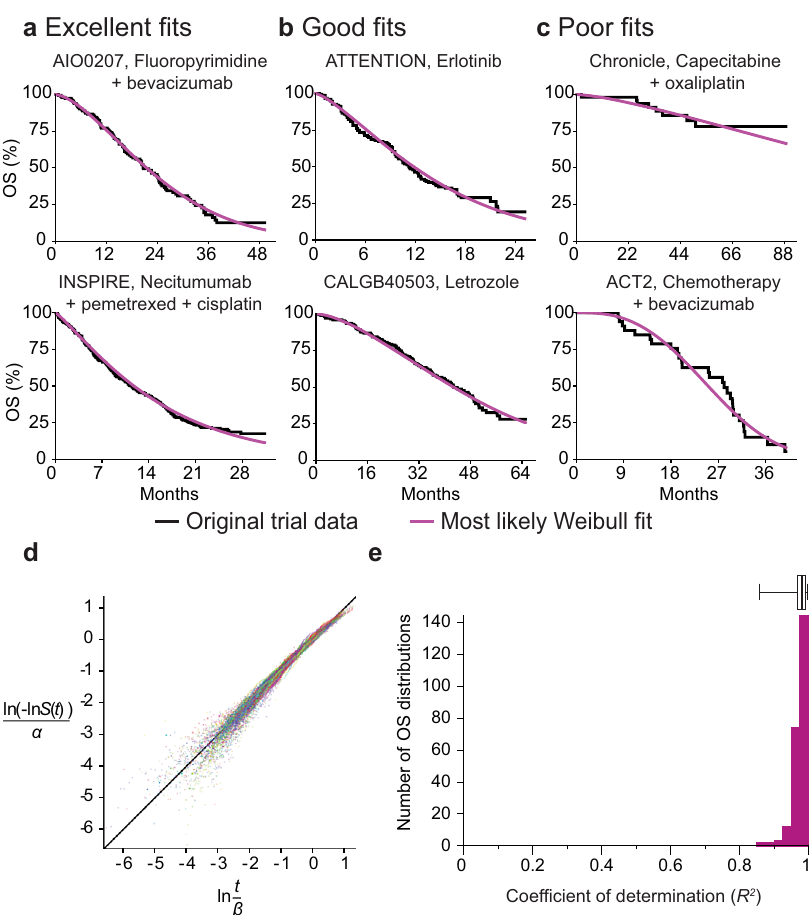
Fig. 2 Representative fi ts of Weibull distributions to overall survival (OS) trial data. a Weibull fi ts to data for plots of the Kaplan – Meier estimator falling in the top 25th percentile quality of all fi ts (NCT00973609, NCT00982111) b between the fi rst and third quartile (NCT01377376, NCT00601900) and c in the lower quartile (NCT00427713, NCT01229813). d Weibull plot for patient events in all OS trials (for 237 trial arms from 116 publication fi gures). This is a transformation of survival data that is linear if the data follow a Weibull distribution. e Goodness of fi t as the coef fi cient of determination ( R 2 ) explained by fi tted Weibull functions for all trial arms reporting OS data ( n = 237 trial arms). Boxplot center line indicates median; box limits indicate the upper and lower quartile values; whiskers span the full data